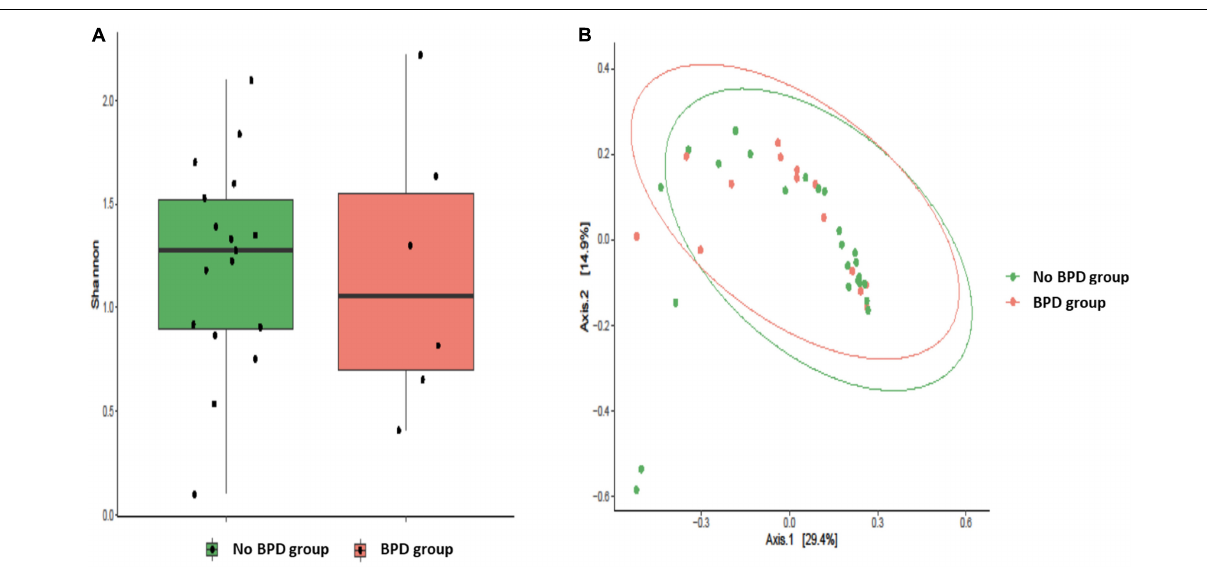
FIGURE 5 | Alveolar microbiota Alpha and Beta diversity analysis of preterm newborns classified on the basis of Bronchopulmonary Dysplasia (BPD) diagnosis. Alpha diversity was evaluated by Shannon index measure. The values obtained were compared, resulting in no statistically significant difference between No BPD and BPD groups (Mann–Whitney U -test) (A) . Comparison for Beta diversity analysis was made using Jaccard distance. The principal coordinate analysis (PCoA) results are presented as two-dimensional ordination plots, which were generated using two principal coordinates (i.e., axis 1 and axis 2) (B) . The statistical significance at a P -value of ≤ 0.05 was assessed using the permutational multivariate analysis of variance